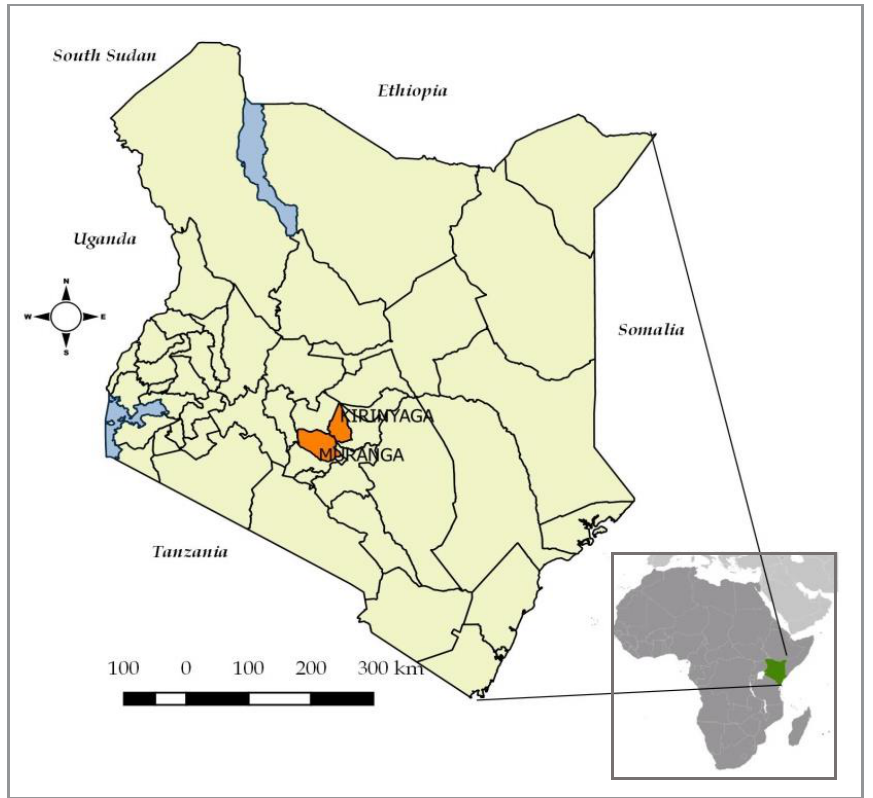
Figure 1: Map of Kenya depicting the two study counties (Muranga and Kirinyaga (Inset: Map of Africa showing position of